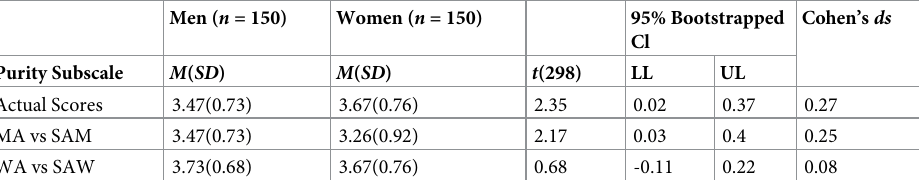
Table 6. Comparison of gender on actual and stereotype scores on purity subscale (N =